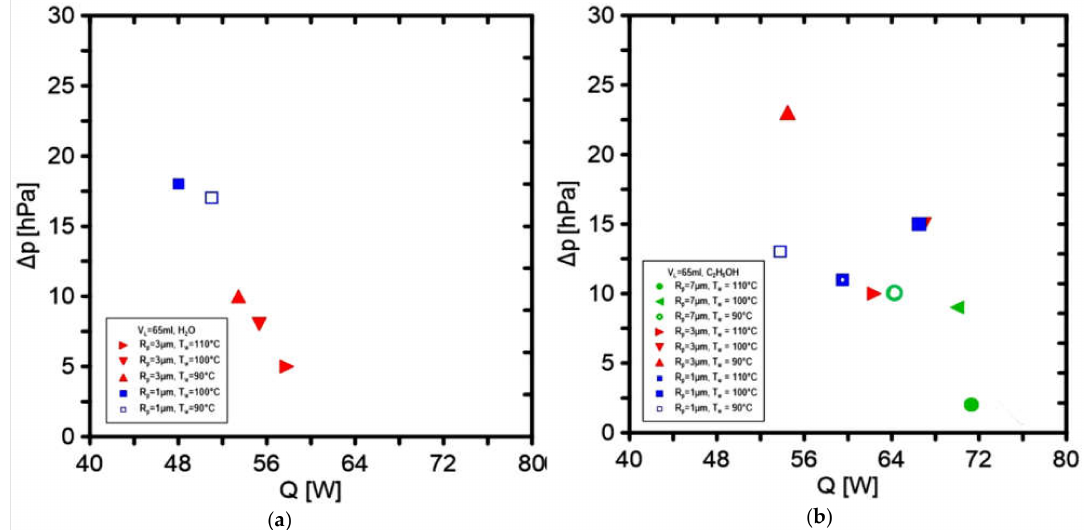
Figure 17. Pressure change in the evaporator in the function of applied heat flux for ( a ) water as a working fluid and ( b ) ethanol as a working